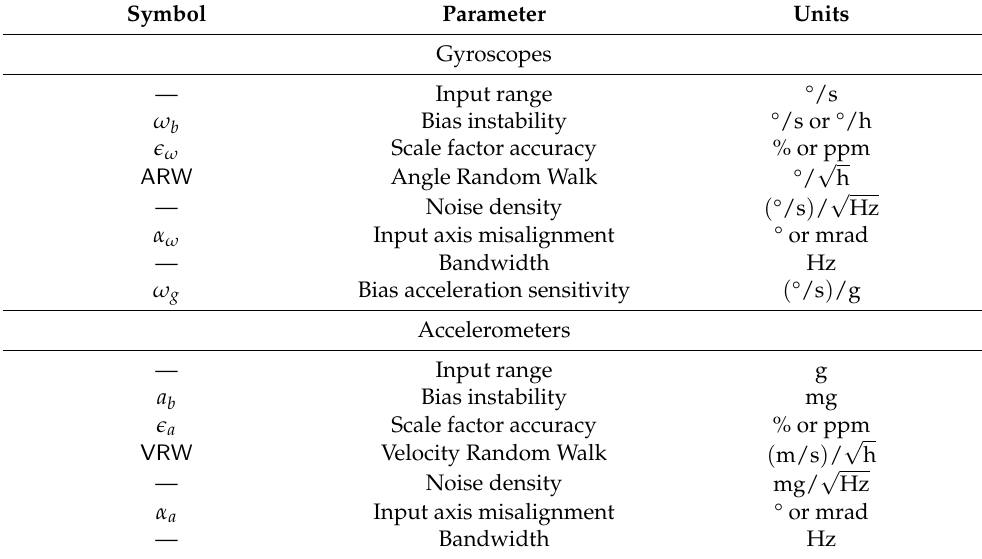
Table 2. The most common parameters used to describe the IMU (based on the review of the existing IMUs’